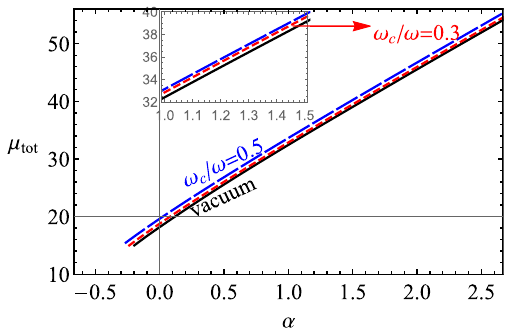
Fig. 6 The total magnification of the images as a function of the MOG parameter.Here,plasmaisdistributedasSISmediumwiththefrequency ω 2 /ω 2 = 0 . 5 at b = 3 M c